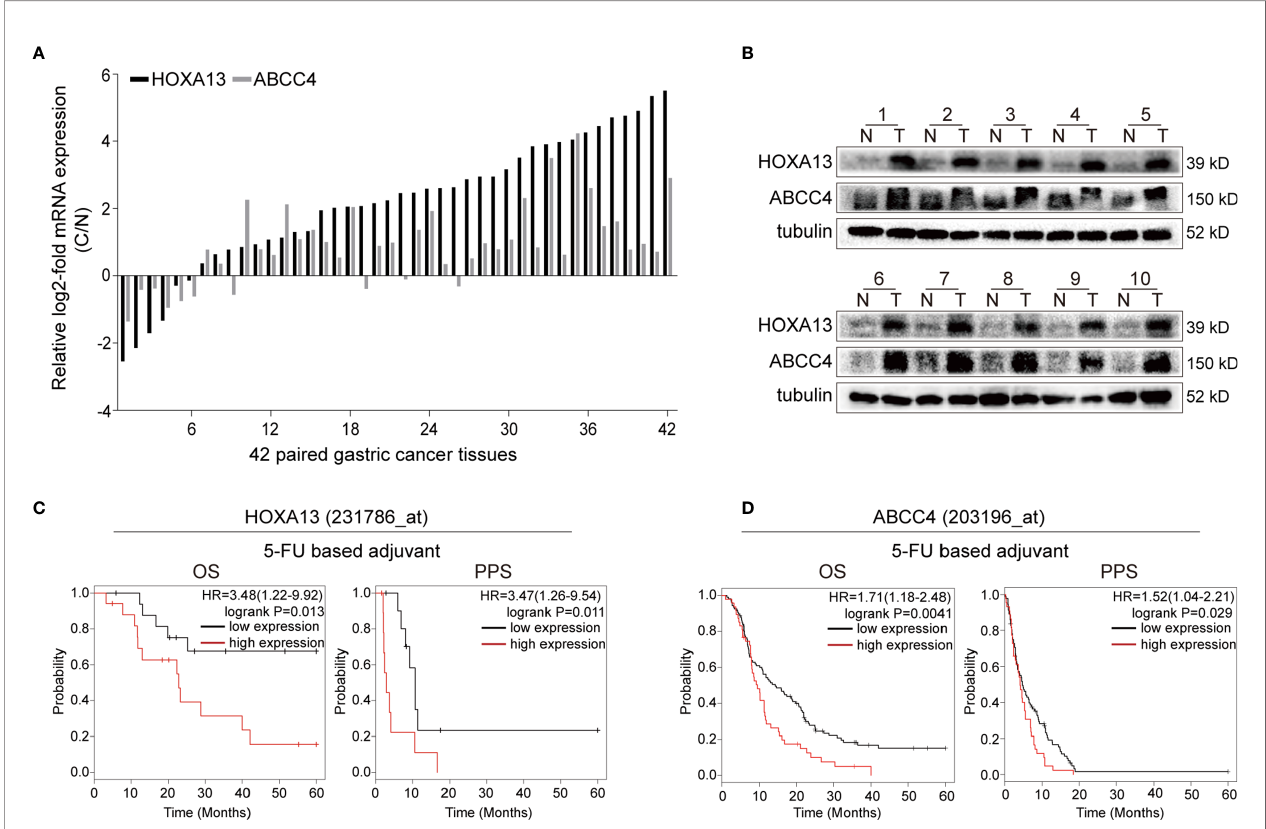
FIGURE 1 | High HOXA13 expression is associated with 5-FU resistance. (A) qRT-PCR analysis of HOXA13 and ABCC4 expression in GC tissues compared with paired normal tissues. (B) Western blot analysis of HOXA13 and ABCC4 expression in GC tissues compared with paired normal tissues. (C) The Kaplan – Meier plotter showed that upregulation of HOXA13 was signi fi cantly associated with lower OS and PPS in GC patients with 5-FU treatment. (D) In 5-FU based chemotherapy, GC patients with high ABCC4 expression had poorer prognosis